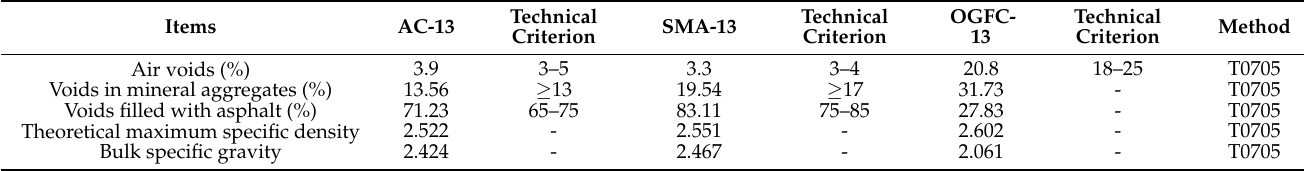
Figure 1. Selected gradation of AC, SMA, and OGFC. Table 3. Volumetric parameters of